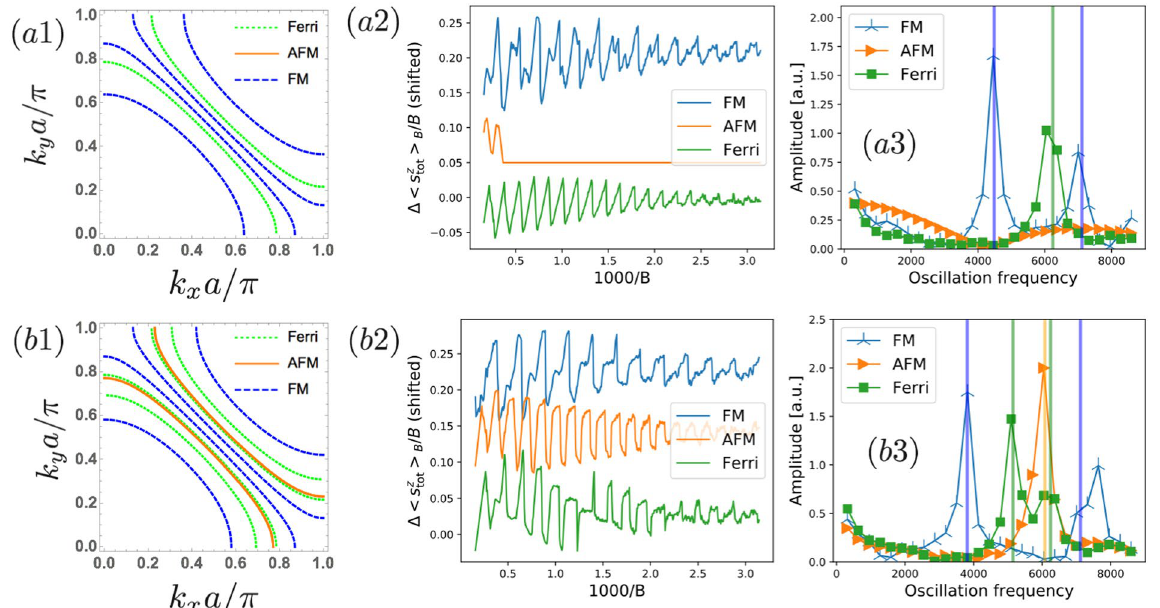
Figure 4. Calculation results of the magnetic oscillation of the model (2) on a lattice with linear dimensions L = for ( a1 – a3 ): E 1 5 F = − . and ( b1 – b3 ): E 2 5 F = − . . We consider three (ferromagnetic, antiferromagnetic, and ferrimagnetic) magnetic orders. ( a1 , b1 ) Fermi surface structures for each magnetic order. ( a2 , b2 ) Field dependence of the electron spin polarization 〉 . The origins are shifted for visibility. These oscillations are Fourier transformed to obtain panels ( a3 , b3 ). The vertical lines in these panels correspond to the oscillation frequency calculated from the area of each extremal Fermi surface [see Eq.